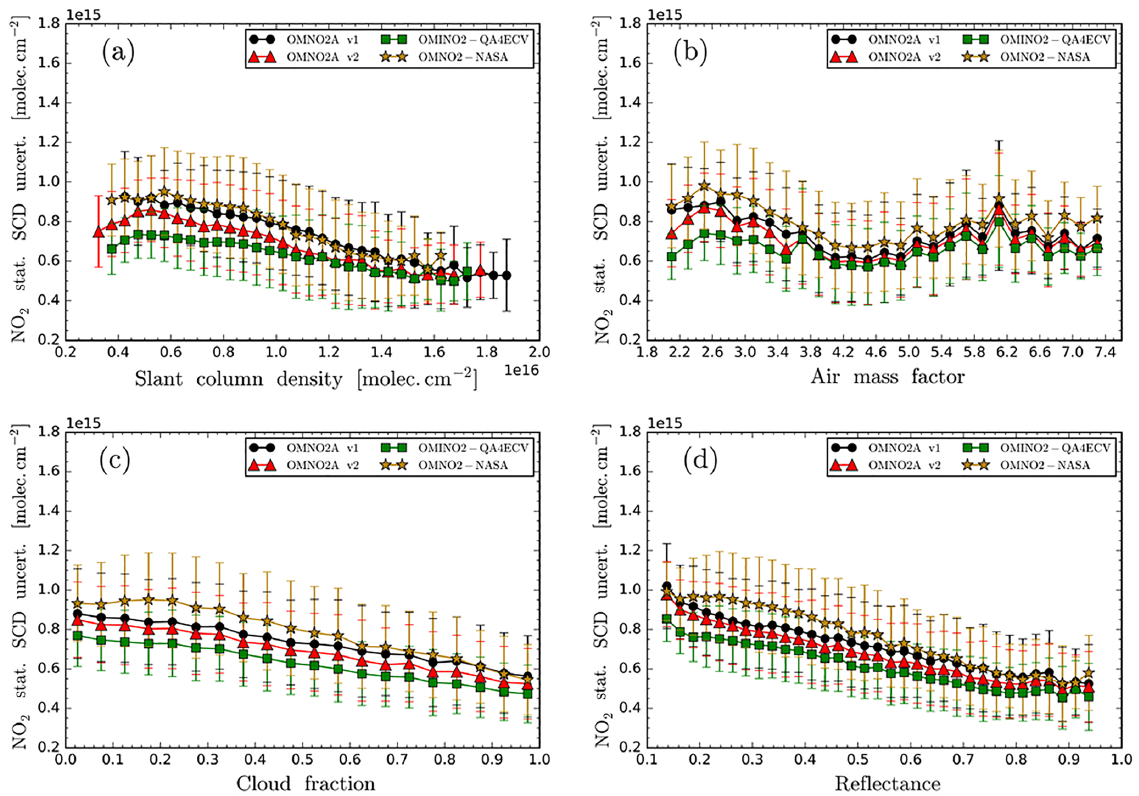
Figure 7. The statistical OMI NO 2 SCD uncertainty as a function of the (a) SCD, (b) AMF, (c) cloud fraction, and (d) the top-of-atmosphere reflectance for the OMNO2A v1 (black circles), OMNO2A v2 (red triangles), OMINO2–QA4ECV (green squares), and the OMNO2–NASA (yellow stars) SCDs for the Pacific orbit from day 1 of January, April, July, and October (or closest available data) 2005–2015. Each bin contains at least 10 boxes for robust statistics and intercomparisons. Error bars represent 1 standard deviation (1 σ)